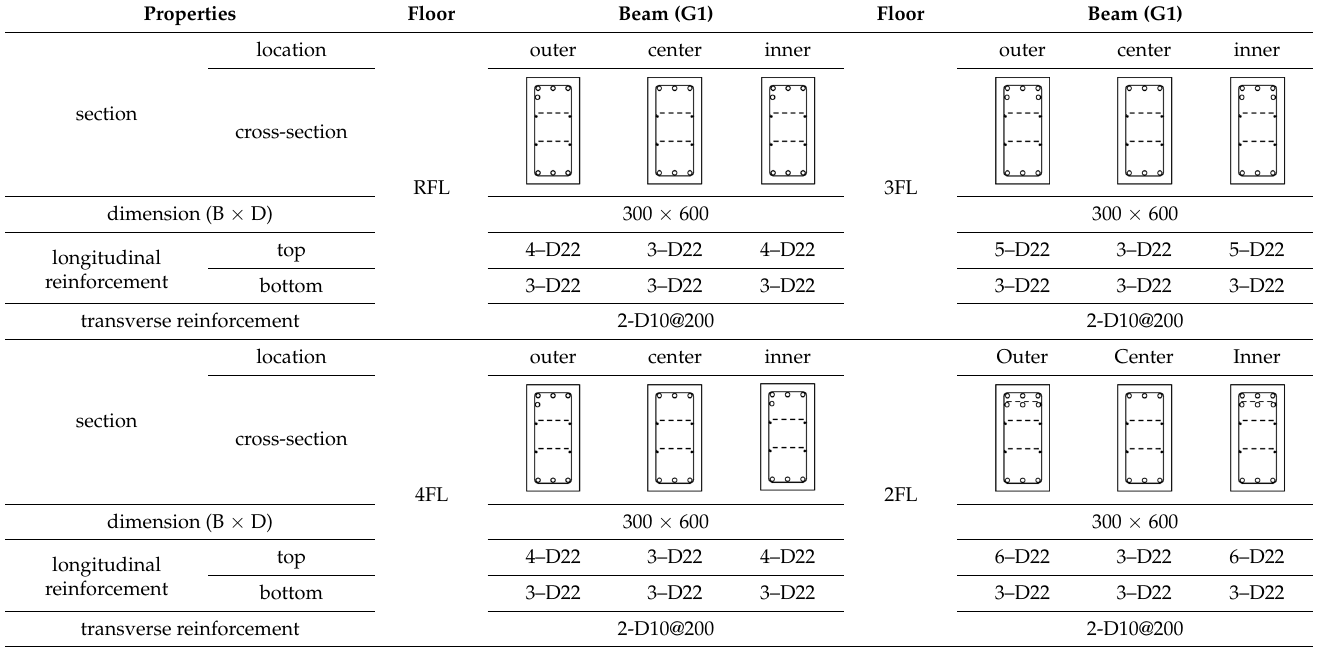
Table 4. Material properties of concrete (Unit: MPa).